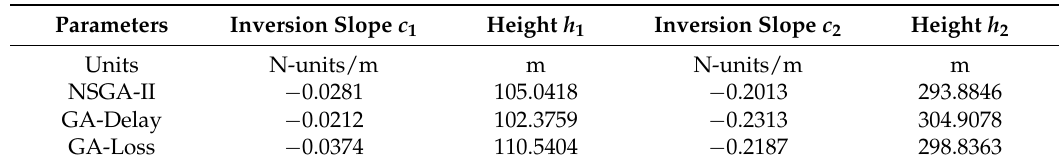
Table 2. The value of inversion parameters by different inversion methods.